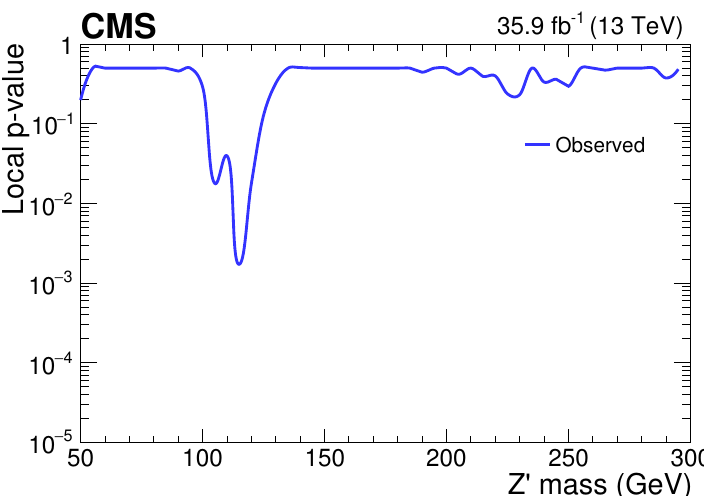
Figure 11 . The observed p-value, obtained from the (cid:12)t to data, as a function of the Z 0 boson mass. The maximum local observed p-value, at 115 GeV, is 1 : 72 (cid:2) 10 (cid:0) 3 and corresponds to 2 : 9 standard deviations from the background-only expectation, and the global p-value, calculated over the probed mass range, corresponds to 0 : 0138 and 2 : 2 standard deviations.